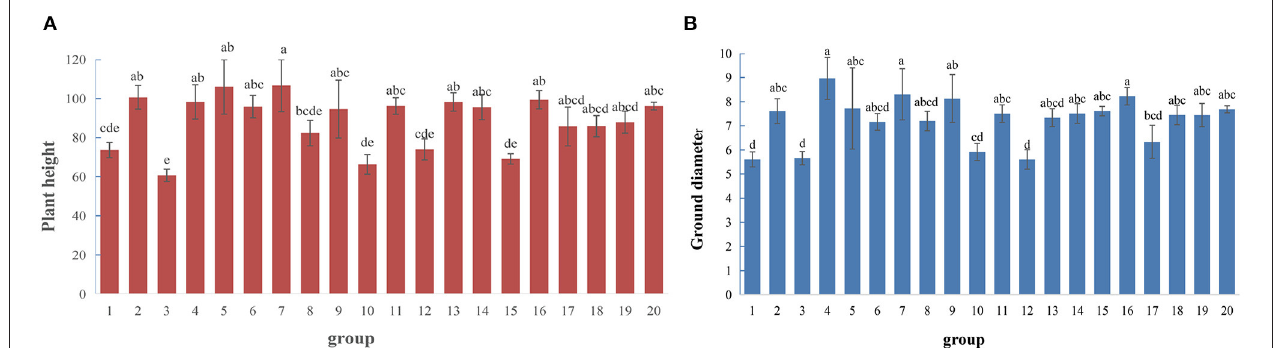
FIGURE 3 | Plant height (A) and ground diameter (B) of the hybrid